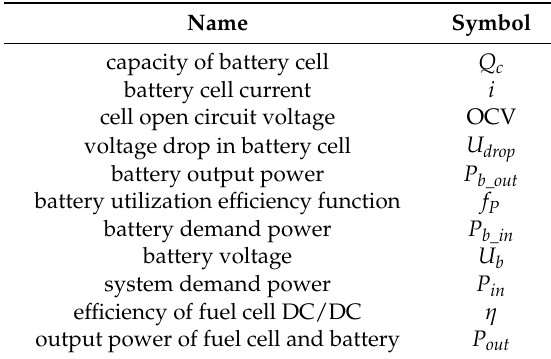
Table 4. Battery symbols.